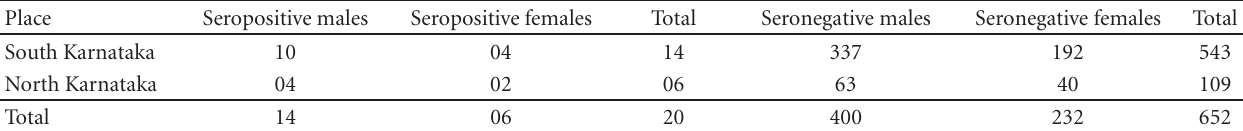
Table 2: Geographical distribution of brucellosis in South Karnataka and North